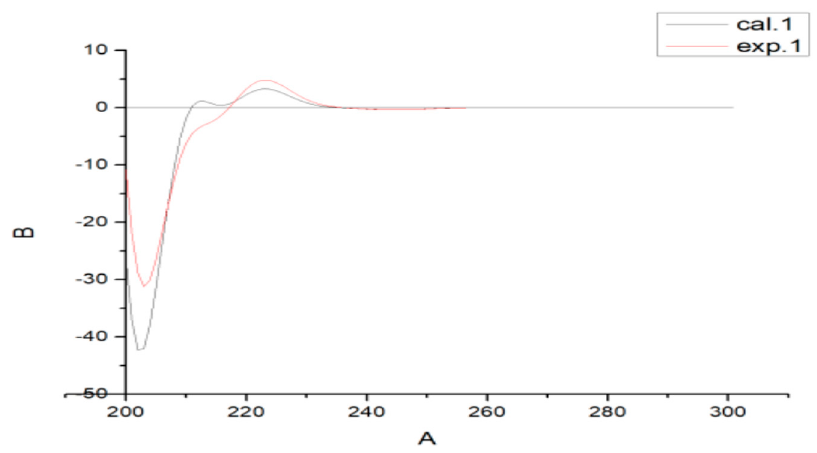
Figure 3. Experimental and calculated ECD spectra of 1.